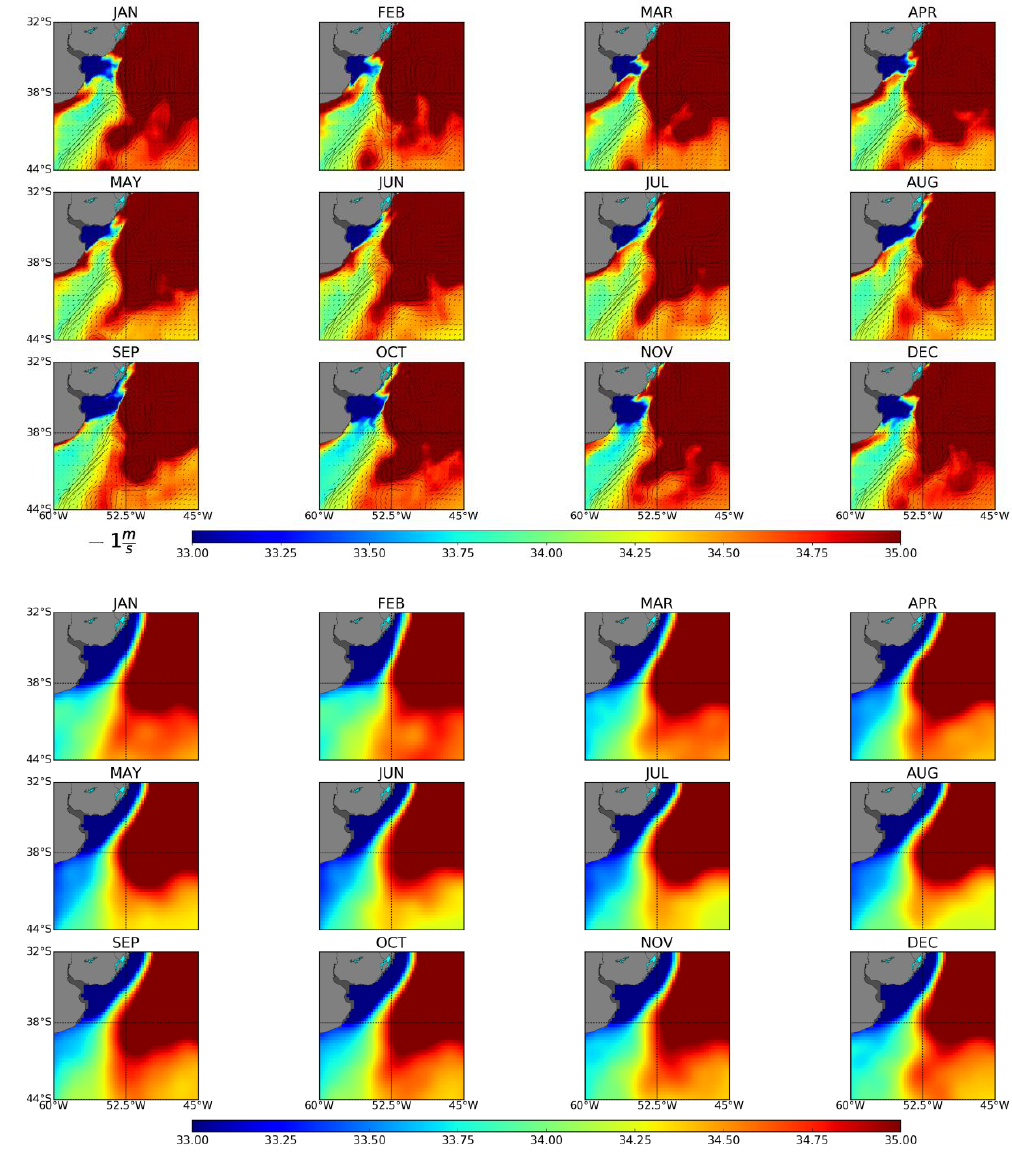
Figure 3. A s in Figure 2 but for the BMC. Figure 3. As in Figure 2 but for the